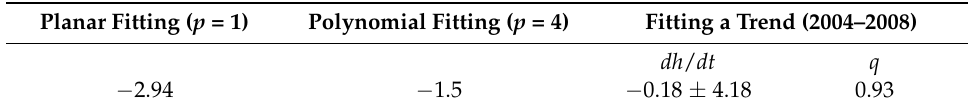
Figure 6. Demonstration of glacial surface with extreme complex topography. Background images are from Google Earth. Footprints is GLAS data. ( a ): Lateral view; and ( b ): front view. Table 7. Glacier thickness change trends on glacier surface with extremely complex topography as shown in Figure 6. q : probability value. The lower the value q , the higher the credibility.